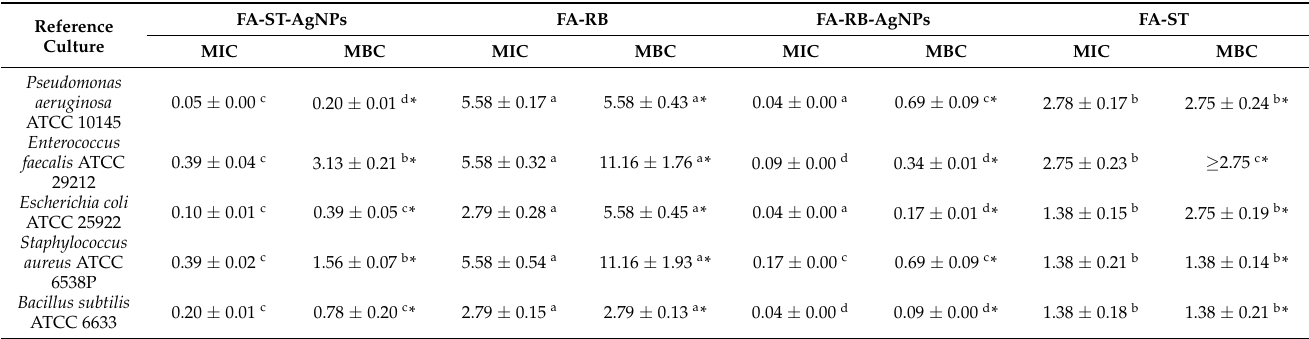
Table 6. Antimicrobial activity of AgNPs according to MIC and MBC (99.5%) values, mg mL − 1